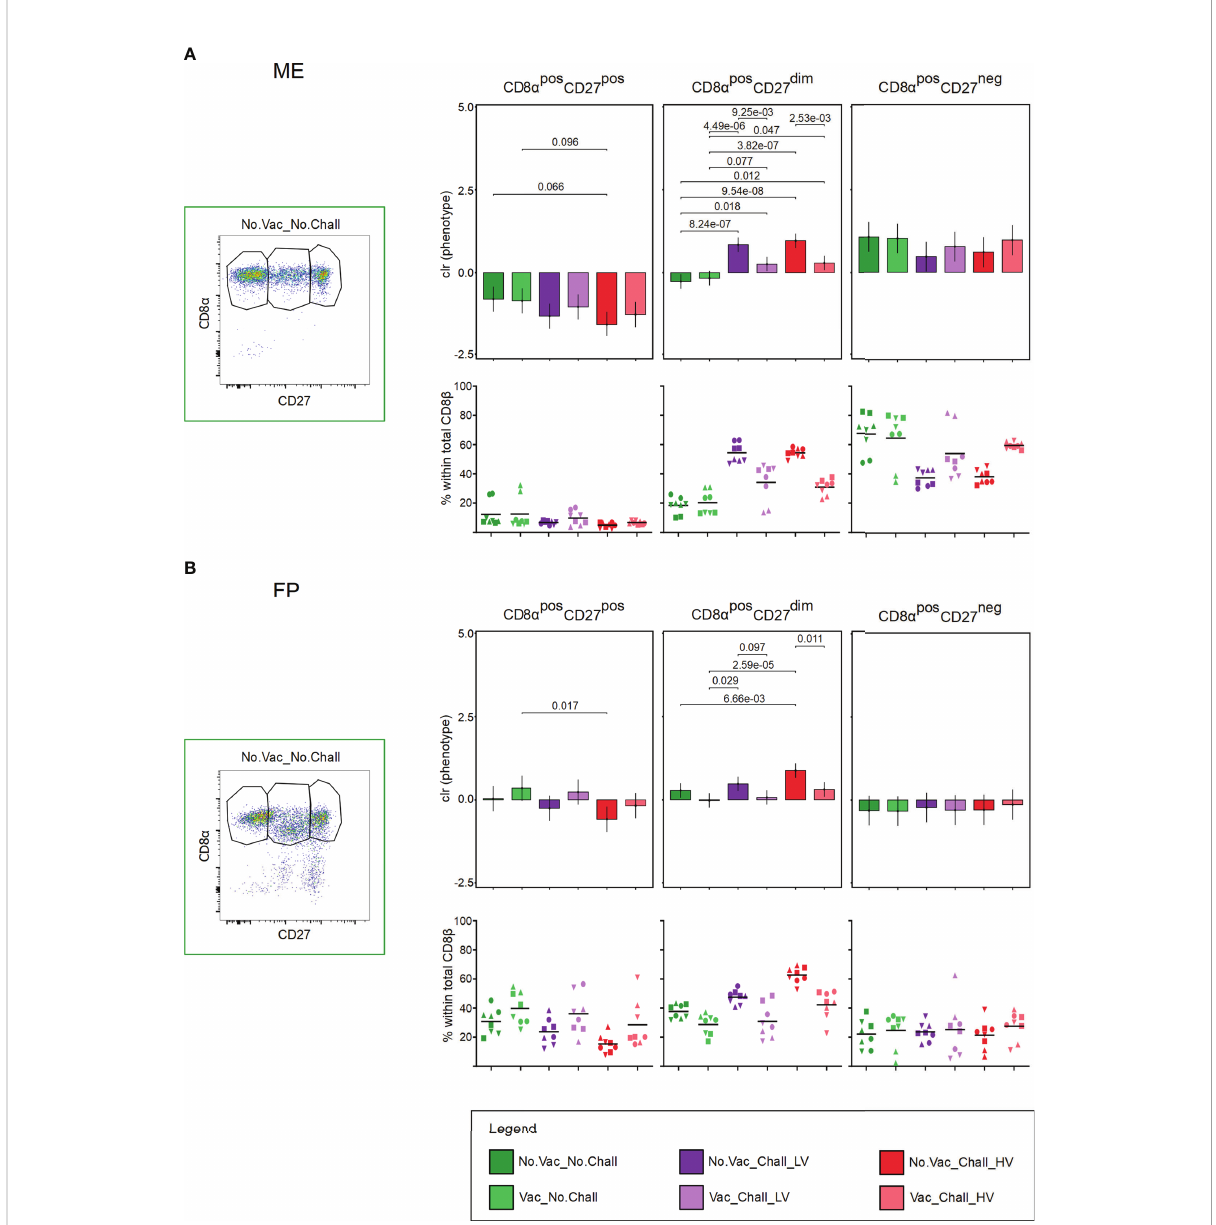
FIGURE 7 CD8 a and CD27 expression of CD8 b T cells at the maternal-fetal interface (A, B) Total CD8 b T cells were investigated for their expression of CD8 a and CD27. CD8 b T cells with a CD8 a pos CD27 pos , CD8 a pos CD27 dim , and CD8 a pos CD27 neg phenotype were identi fi ed and presumably represent naive, early effector, and late effector CD8 T cells, respectively. Representative pseudocolor plots for the (A) maternal endometrium (ME) and the (B) fetal placenta (FP) from a No.Vac_No.Chall fetus are shown. Representative pseudocolor plots for the (A) ME and the (B) FP from a No.Vac_No.Chall fetus are shown. Univariate compositional data analysis was performed for the three CD8 a /CD27-de fi ned CD8 b T cell subsets. Results are represented in the bar charts (top panel; (A) ME; (B) FP). The y-axes depict the estimated marginal means (emmeans) of the centered log ratios (clr) transformed speci fi ed CD8 b T cell subset. Only signi fi cant p-values (p < 0.1), corrected for multiple testing using a false discovery rate approach, across all pairwise comparisons of contrasts for all (nine) compositional cell subsets and both tissues, are shown above the brackets. The whiskers depict the 95% con fi dence intervals of the clr-transformed data. The graphs in the bottom panel (A) ME; (B) FP) show the frequencies of the CD8 a /CD27-de fi ned subsets within total CD8 b T cells. For all graphs, results for each individual fetus are shown and different symbols indicate fetuses from different gilts. The black bars in the graphs display the mean within the respective treatment group. For all bar plots and graphs shown, the depicted treatment groups are: No.Vac_No.Chall (dark green, non-vaccinated and non-infected), Vac_No.Chall (light green, vaccinated and non-infected), No.Vac_Chall_LV (dark purple, non-vaccinated and infected low virulent strain), Vac_Chall_LV (light purple, vaccinated and infected low virulent strain), No.Vac_Chall_HV (dark red, non-vaccinated and infected high virulent strain), and Vac_Chall_HV (light red, vaccinated and infected high virulent